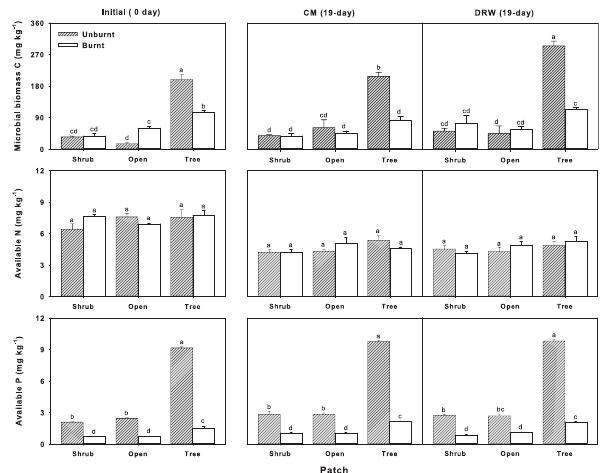
Figure 3. Soil microbial biomass C, available N and P in soil under shrubs and trees or in open areas of unburnt and burnt mallee woodlands at the start (initial) and end of the exper- iment in constantly moist (CM) and drying–rewetting (DRW) treatments (mean ± standard error, n = 4). Different letters indi- cate significant differences for the three-way interaction burn- ing × patch × moisture treatment interaction at p